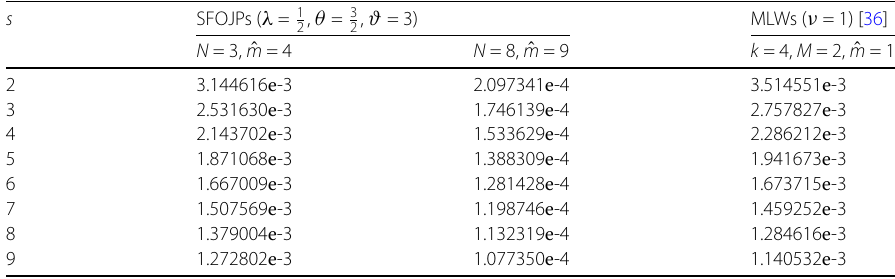
Table 4 Absolute errors at the interval [0,10), for Example